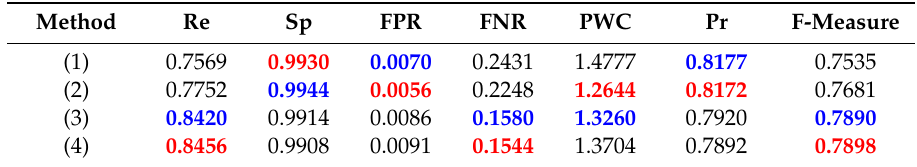
Table 6. Performance analysis of four cases on CDnet2014